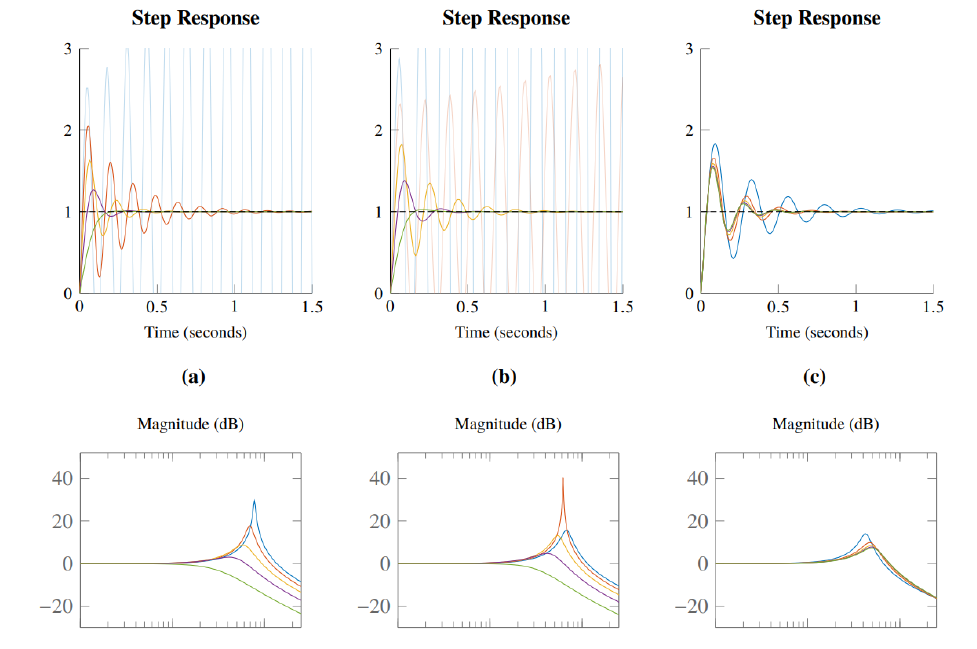
Figure 12. Step responses and bode plots of the INDI loop with exta loop delay d = 1.1 T s ( 22 ms ) , comparing: ( a ) ISG values with ideal state feedback; ( b ) ISG values with ω n T s = 15 in the SOD; ( c ) SOD frequencies with ISG of λ =